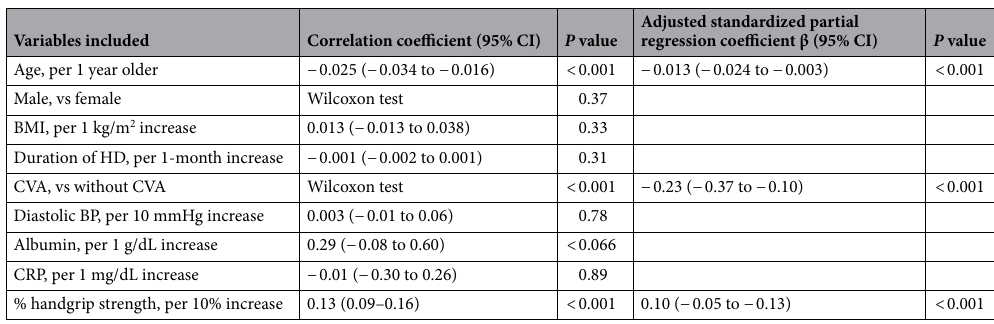
Table 3. Correlation coefficients and multivariate analyses of variables related to the MoCA-J executive score. Adjusted for all listed variables. MoCA-J Japanese version of the Montreal Cognitive Assessment, CI confidence interval, BMI body mass index, CVA cerebrovascular disease; CRP C-reactive protein, BP blood